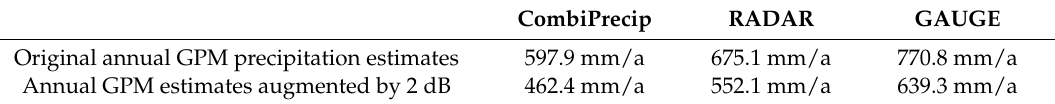
Table 4. Root Mean Square Error (in mm/a) between the GPM estimates (version V05A) above 221 Swiss sites and the estimates derived from three different MeteoSwiss precipitation products.